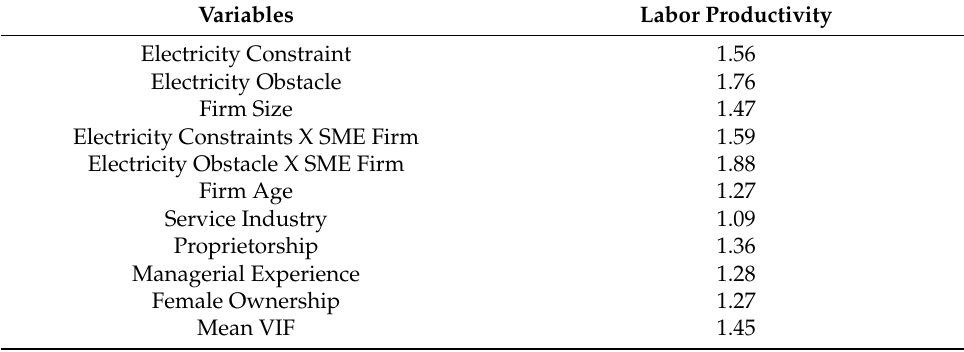
Table 4. Detecting multicollinearity among variables using variance inflation factor